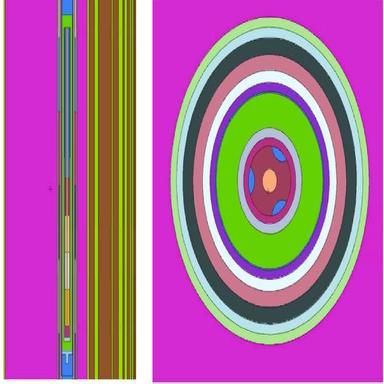
Shows an axial cross section (left) and top-down cross section (right) view of the IMPACT slotted fuel outer capsule as modeled in MCNP.